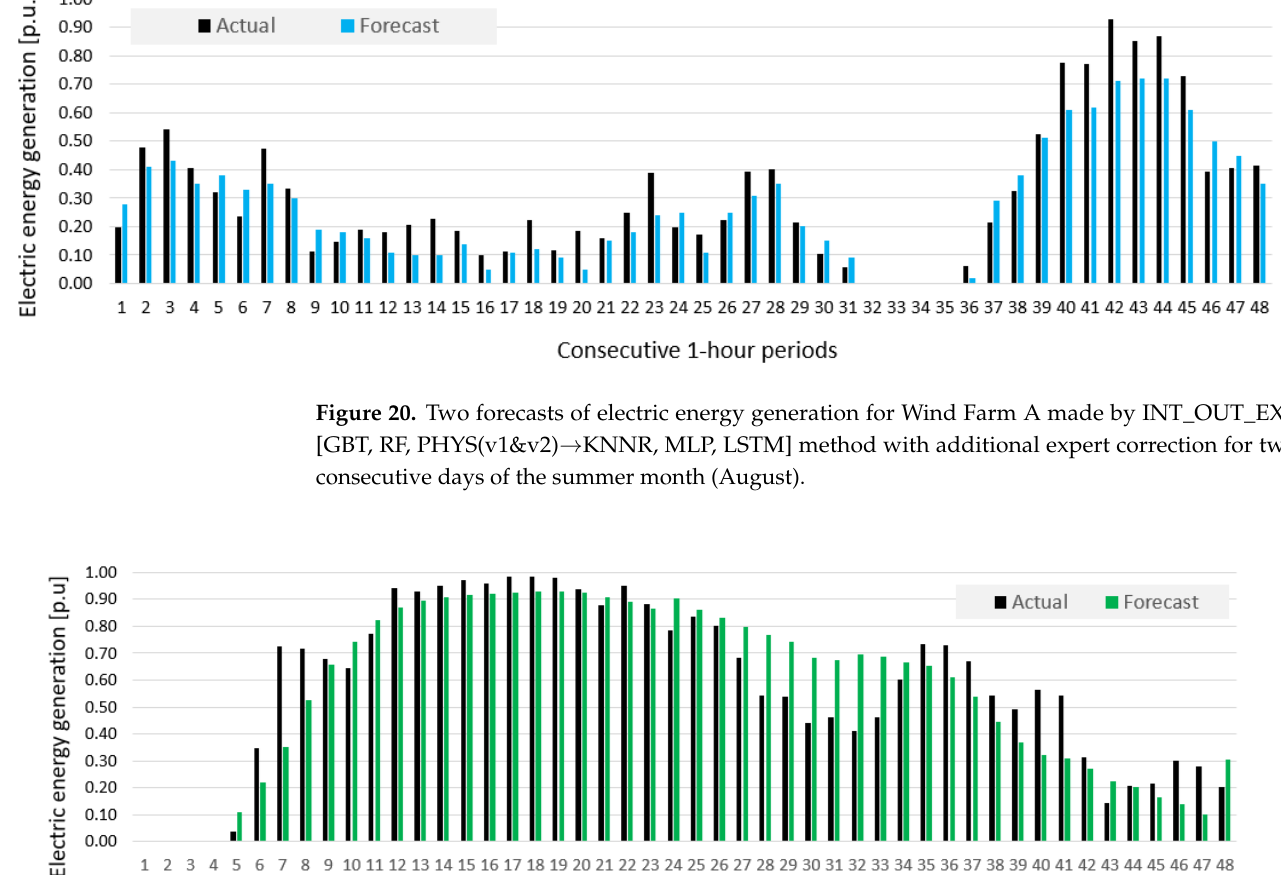
consecutive days of the spring month (April).